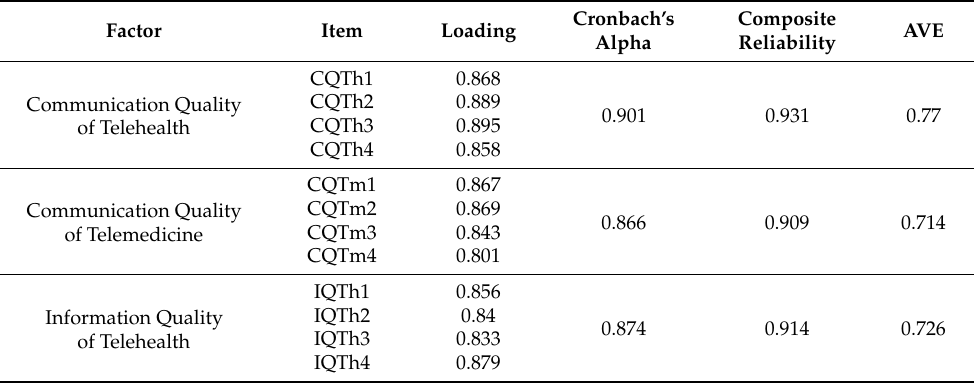
Table 4. Descriptive statistics of the elements